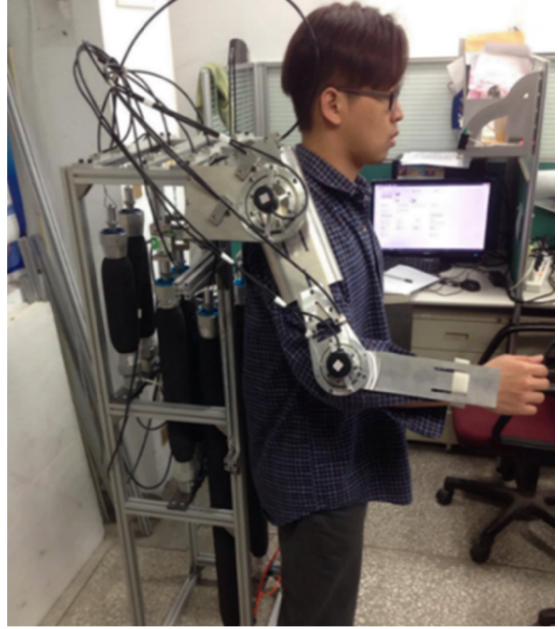
Figure 1. Schematic diagram of robotic arm structure.